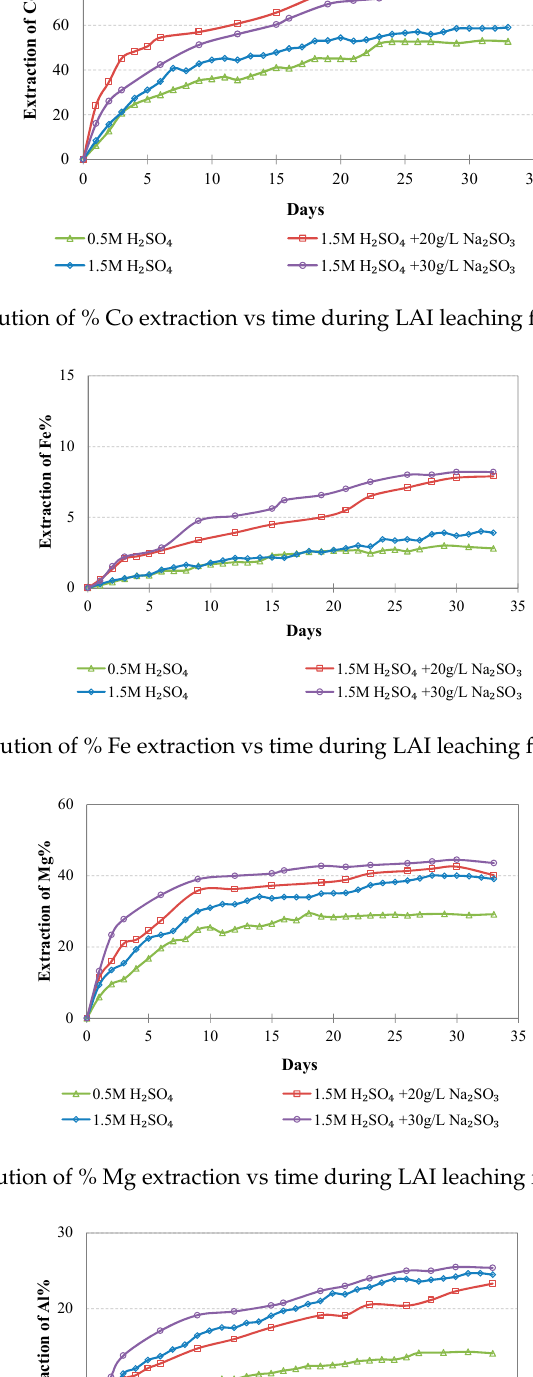
Figure 10. Evolution of % Ca extraction vs time during LAI leaching for different tests.